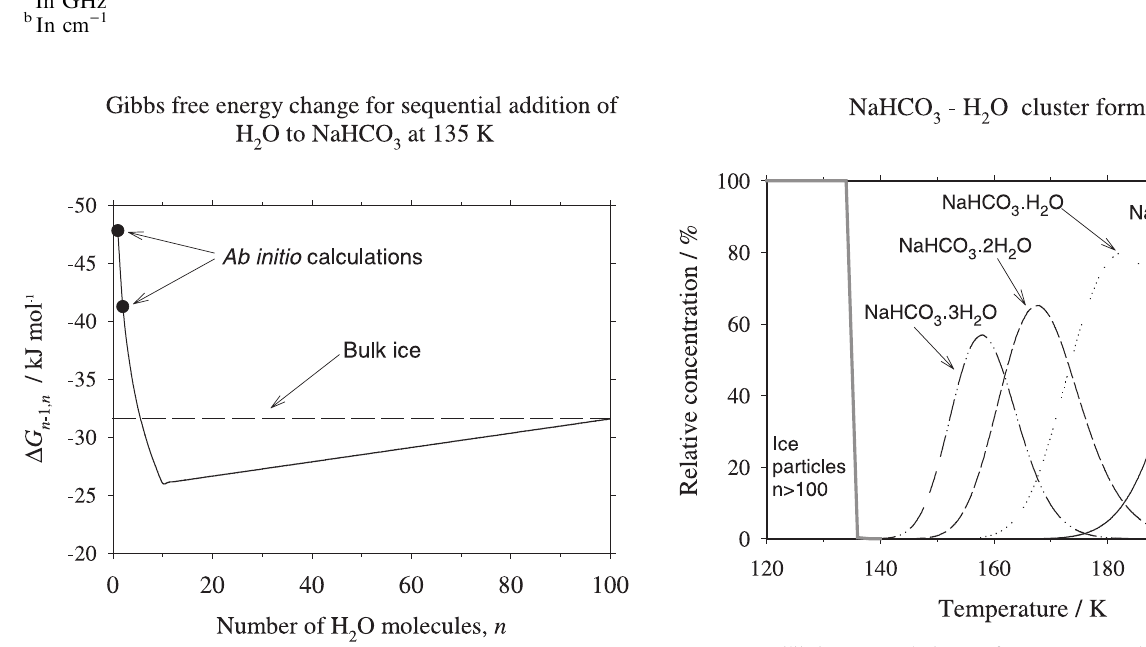
Fig. 4. Hypothetical dependence of D G the addition of the n th H function of n at 135 K. D G ab initio quantum calculations. The value for bulk ice is extrapolated from the measurements of Marti and Mauersberger (1993)